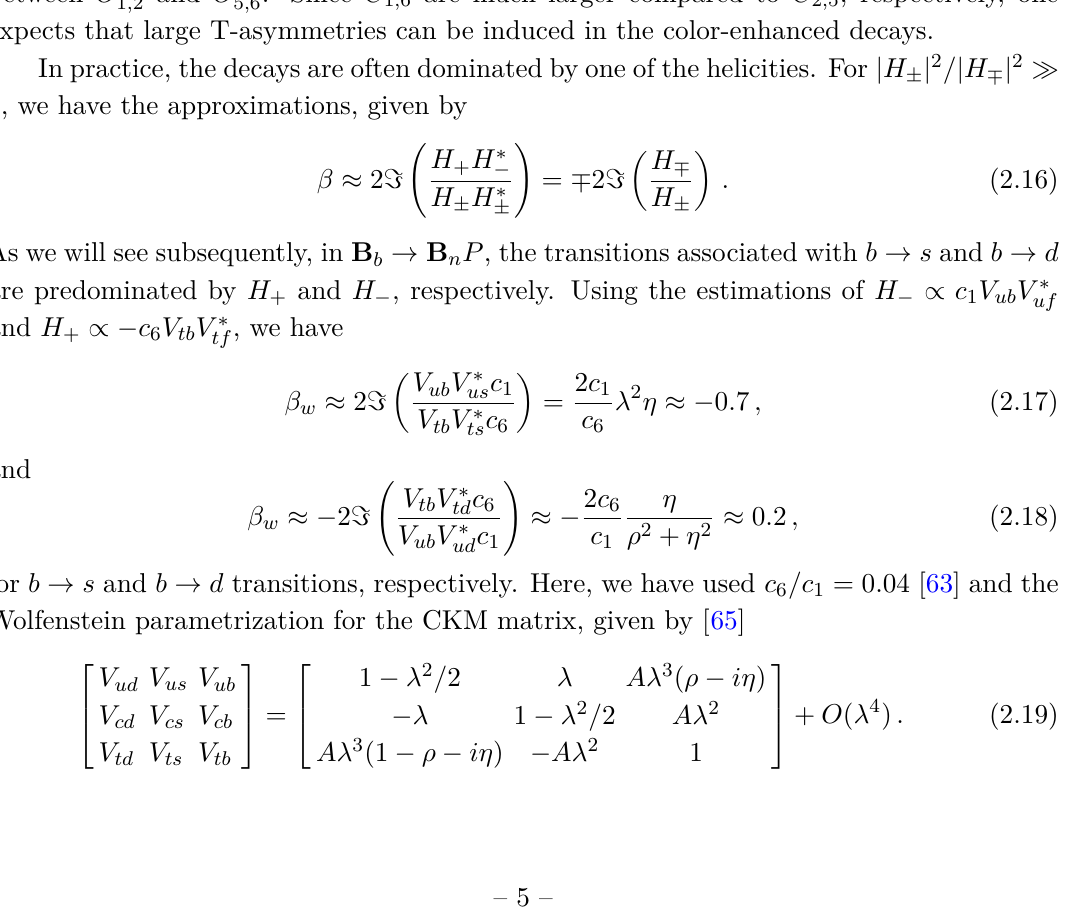
and V tb V ∗ , us ts